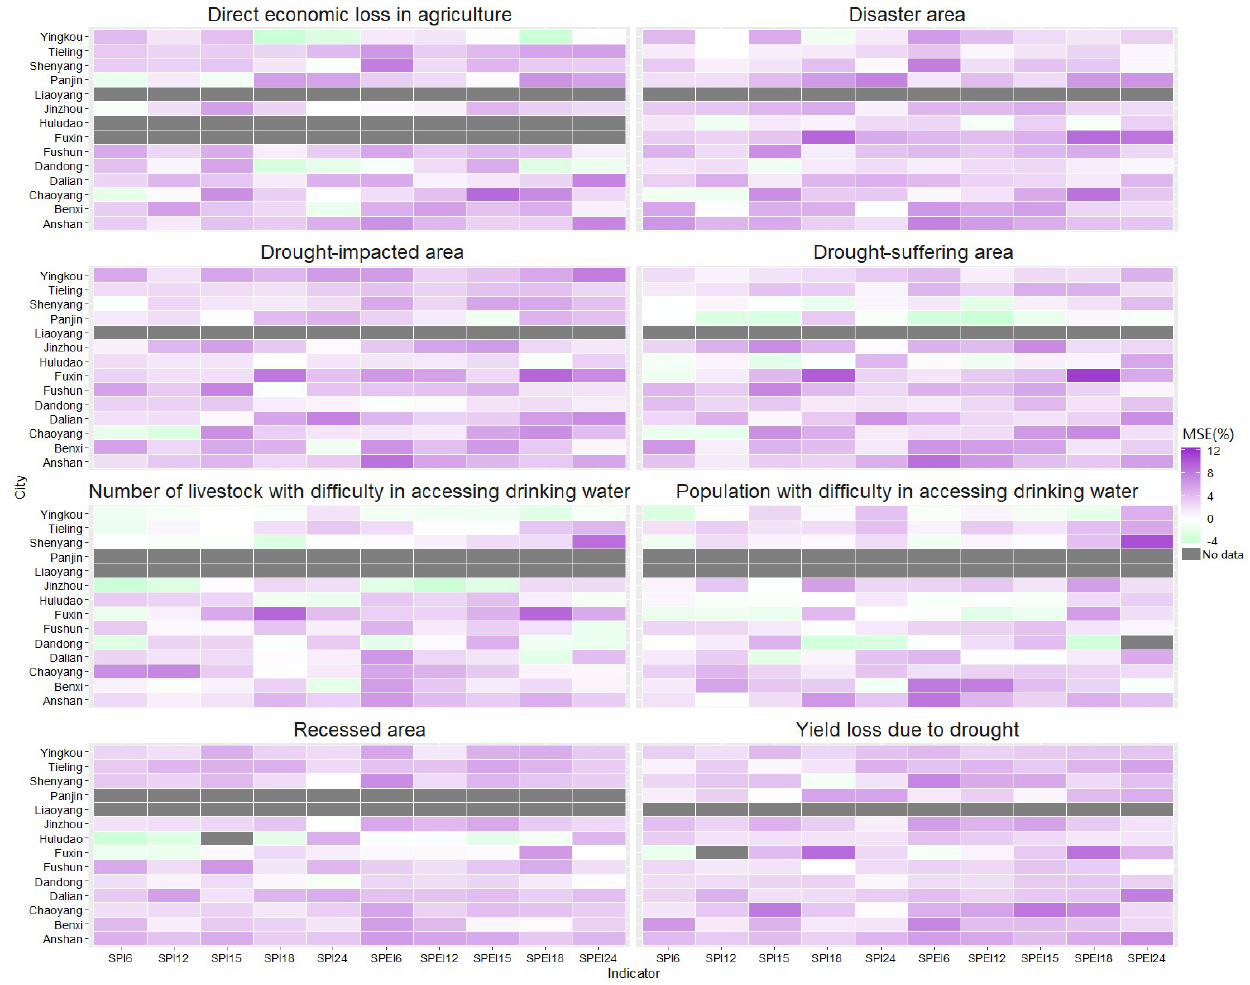
Figure 5. The MSE % of drought indices (SPI and SPEI) with drought impacts (identified by the codes in Table 1) in Liaoning province using random forest.